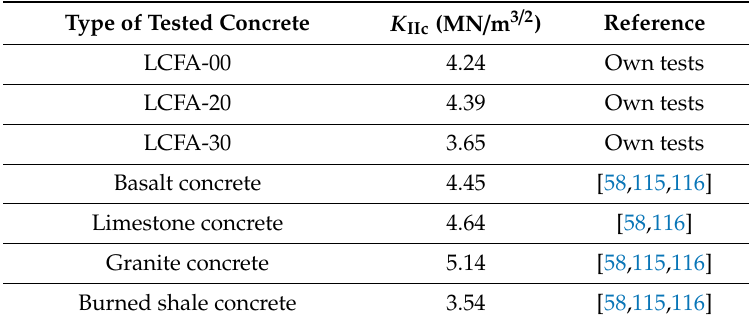
Table 7. Comparison of the results of own tests of the fracture toughness K IIc with the results of other